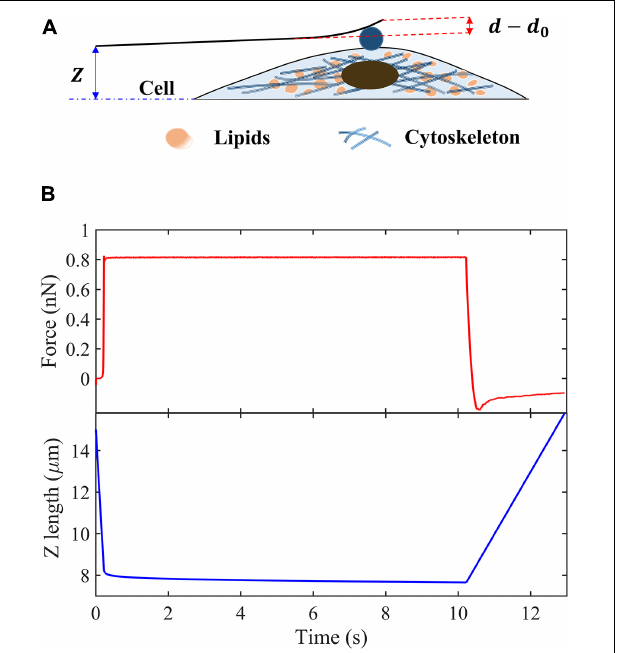
FIGURE 1 | Schematic of creep experiments on living cells. (A) Schematic of the indentation experiment. (B) Indentation force and Z-position of the cantilever base in the creep